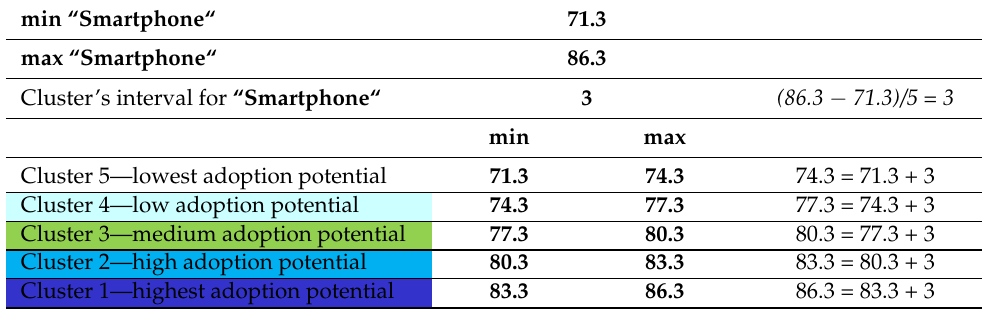
Table 11. Calculations for the “cluster interval” for variable “Smartphone“.